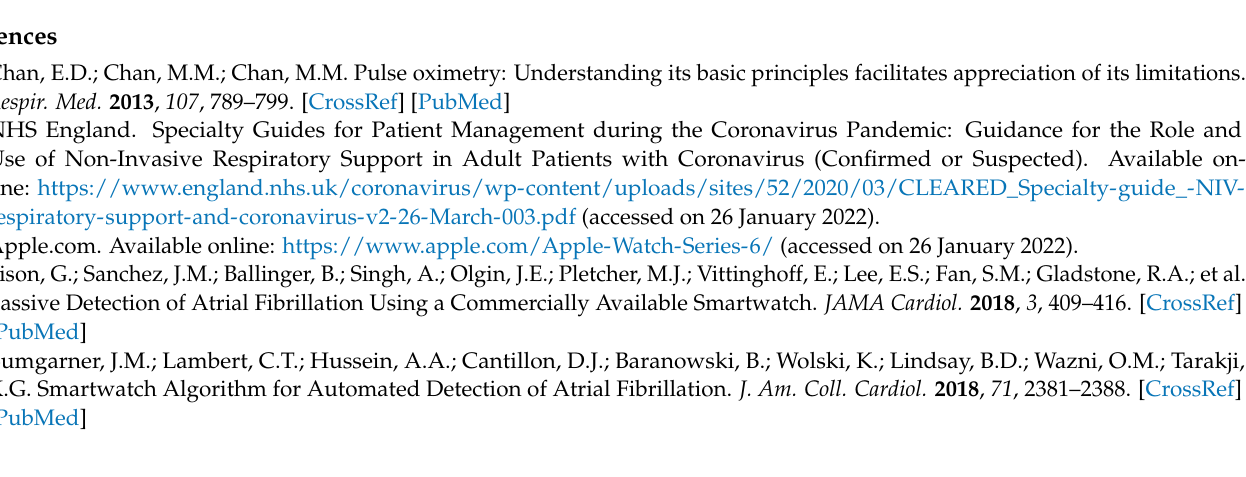
Table S2. SpO 2 Concordance between the smartwatch and the standard commercial device in difference subgroups. Table S3. HR Correlation between the smartwatch and the standard commercial device in different subgroups. Table S4. HR Concordance between the smartwatch and the standard commercial device in difference